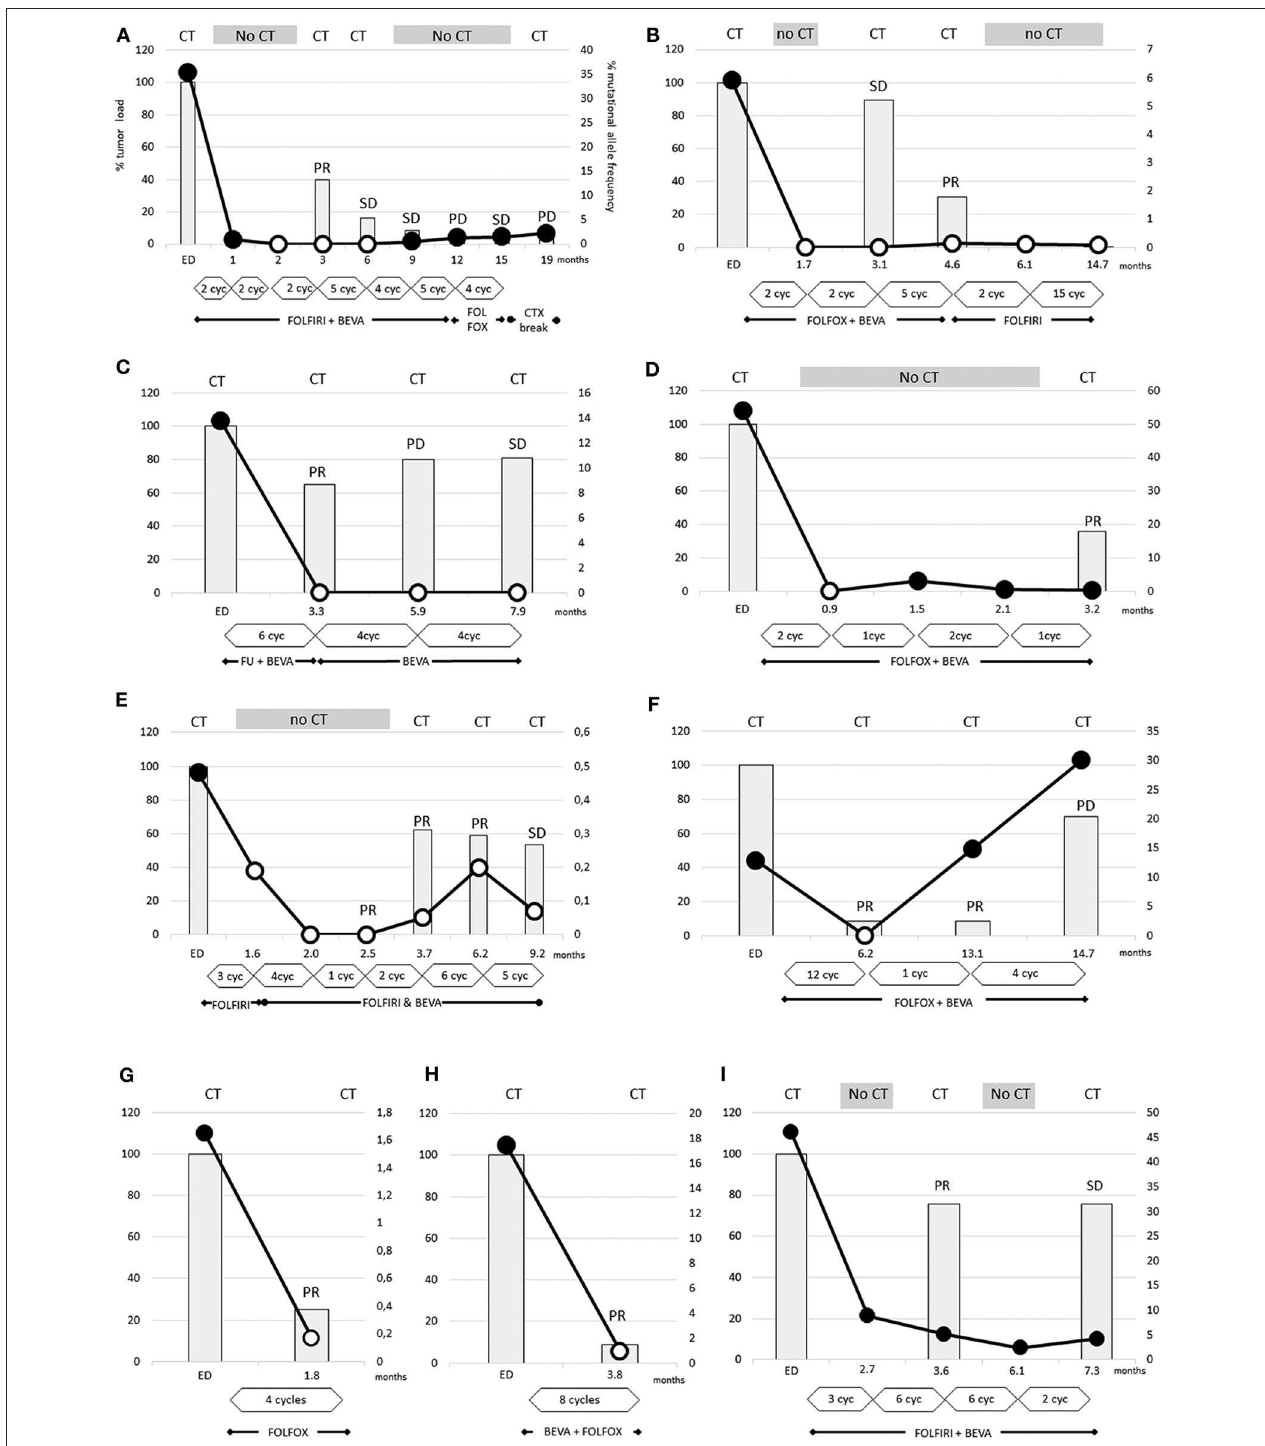
FIGURE 2 | The dramatic decrease of RAS mutational load was detectable after 2 cycles (A,B,D) and the disappearance of RAS mutations occurs earliest after 2 cycles of therapy (B,D). In other cases (A,C,E–H) the disappearance is obvious after 4–12 cycles of therapy. The tumor loads, measured by CT scans, were strongly reduced by 75–90% in two cases (F–H) , and more moderately reduced by 20–60% in other cases (A–E) . In case (I) , despite the dramatic decrease of RAS mutational load the Ras mutations remained detectable. (A) Patient 7, (B) patient 8, (C) patient 2, (D) patient 6, (E) patient 10, (F) patient 9, (G) patient 1, (H) patient 5, and (I) patient